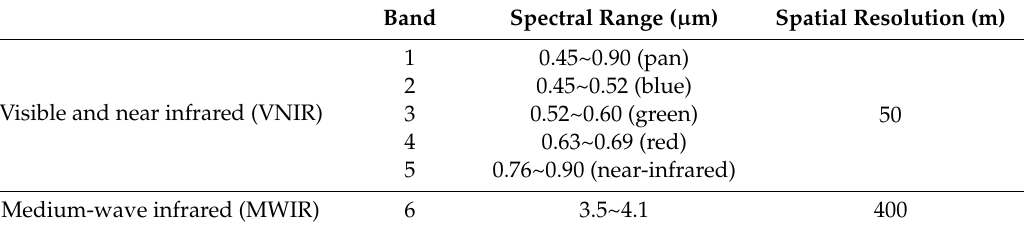
Table 1. Primary characteristics of each payload of GF-4.